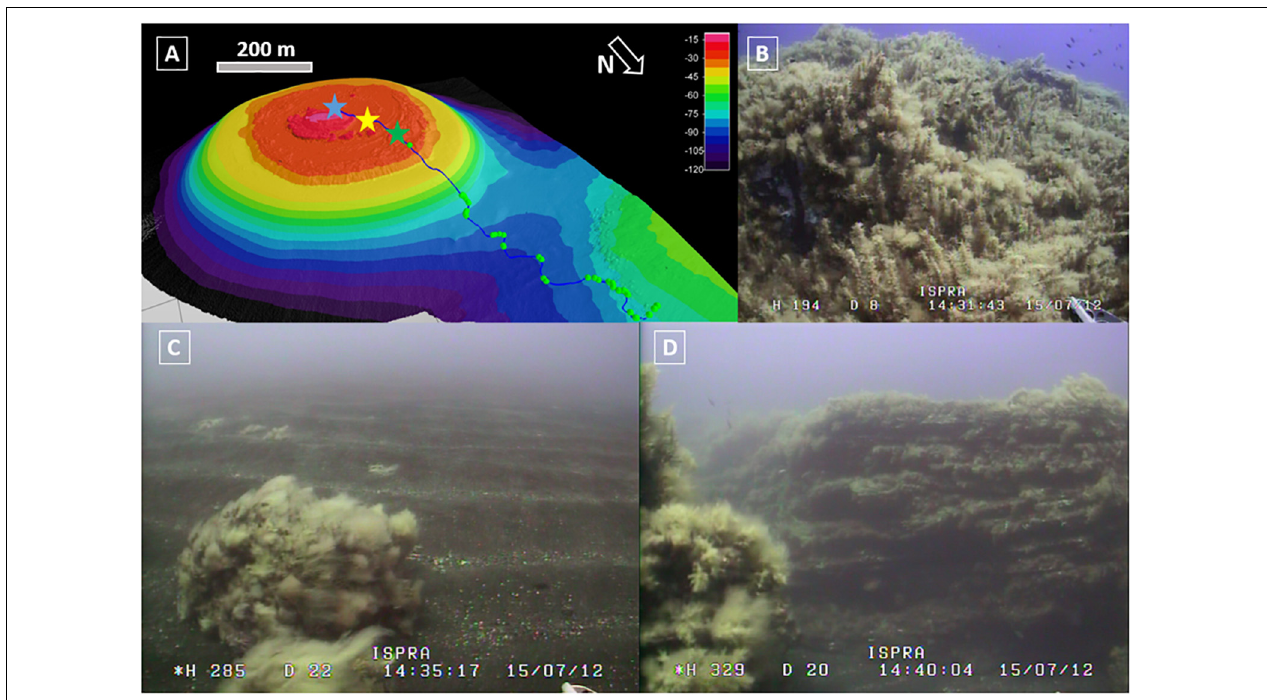
FIGURE 7 | (A) ROV dive on top of the Ferdinandea shoal (S4). The blue star indicates the location of (B) showing the volcanic knoll, which represents the shallowest point ( − 9 m) of the whole field, completely colonized by gorgonians. The yellow star points to the location of (C) displaying the seafloor of the summit terrace characterized by black sand ripples. Finally, the green star indicates the location of (D) where the furrows are imaged.